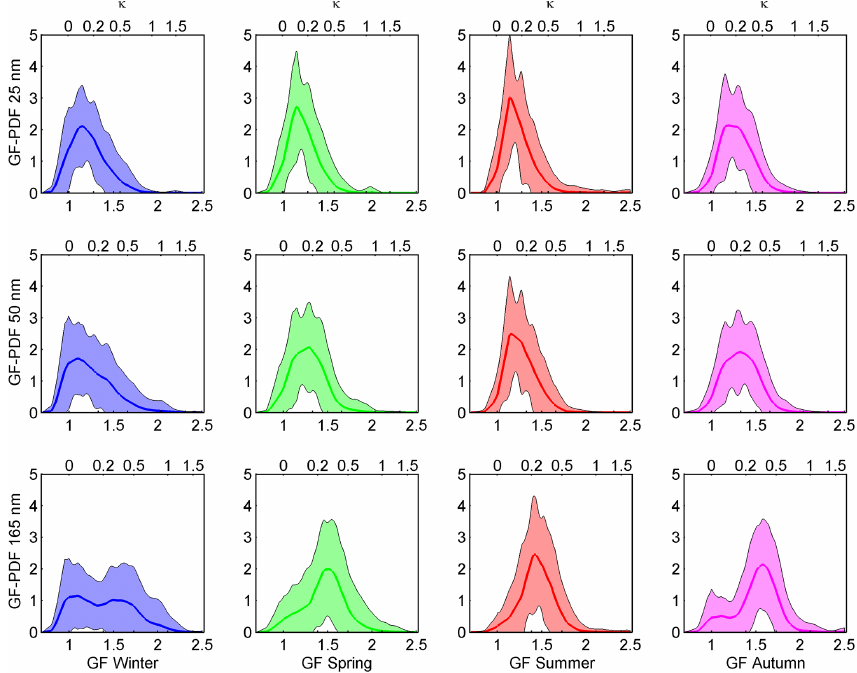
Figure 4a. Average GF-PDFs and their standard deviations for particles in the nucleation mode (top panels), Aitken mode (middle panels) and accumulation mode (bottom panels), split by season and measured at RH90. The bottom axis gives the growth factor GF and the top axis shows the corresponding kappa value κ